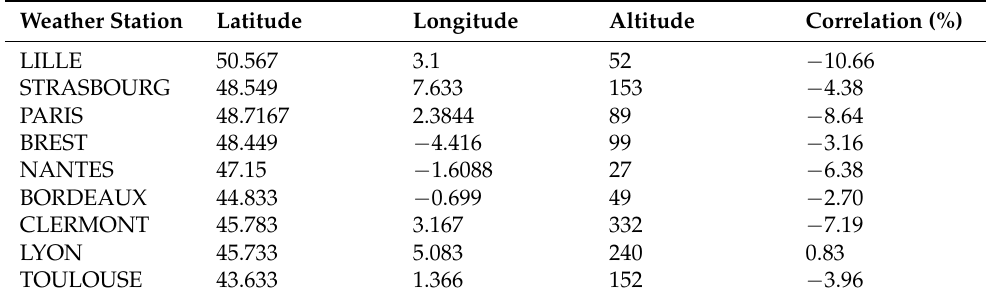
Table 2. Correlation between EPEX spot day-ahead electricity auction price and hourly wind speed (m/s). Weather Station Latitude Longitude Altitude Correlation (%) LILLE 50.567 3.1 52 − 10.66 STRASBOURG 48.549 7.633 153 − 4.38 PARIS 48.7167 2.3844 89 − 8.64 BREST 48.449 − 4.416 99 − 3.16 47.15 − 6.38 BORDEAUX 44.833 − 0.699 49 − 2.70 45.783 − 7.19 LYON 45.733 5.083 240 0.83 TOULOUSE 43.633 1.366 152 −